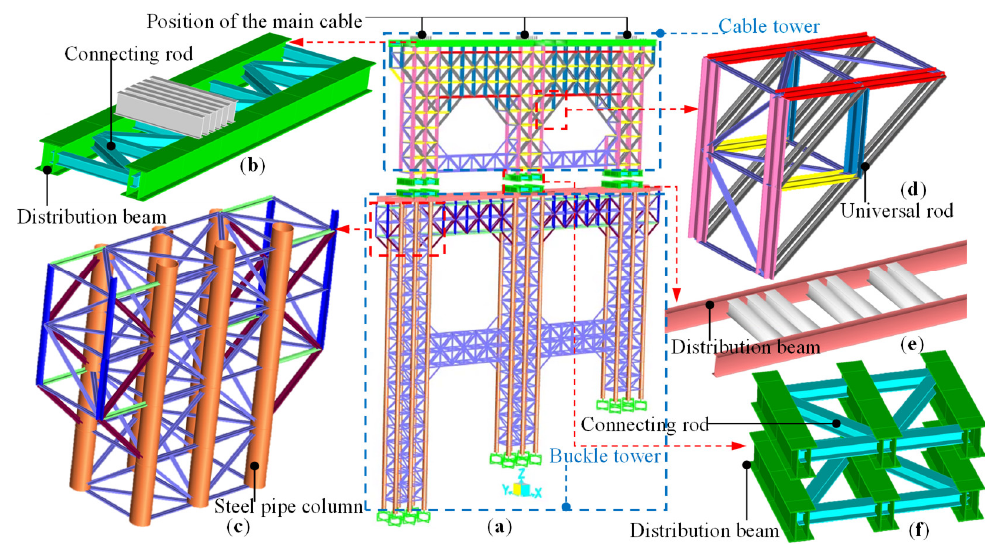
Figure 8. Numerical calculation model of tower: ( a ) tower; ( b ) distribution beam at top of cable tower; ( c ) steel pipe column and universal rods; ( d ) universal rods; ( e ) distribution beam at top of buckle tower; ( f ) hinge seat distribution beam. Table 2. Physical and mechanical property parameters of steel.